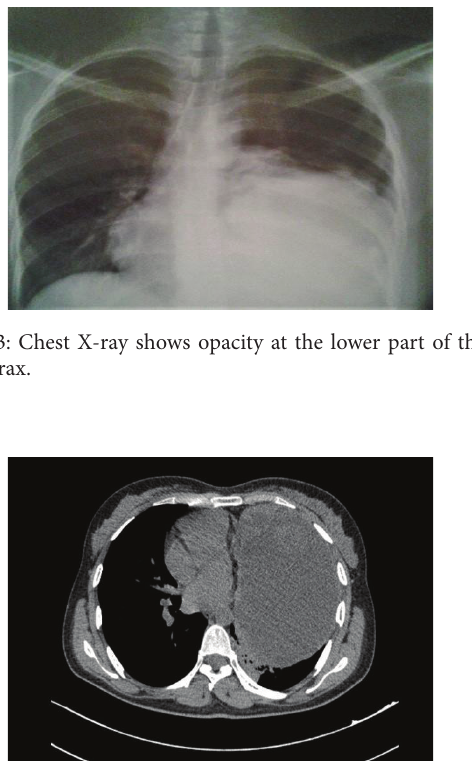
Figure 4: CT scan of chest shows a mass of the left hemithorax, which probably originated in the mediastinum and extended to the whole left pleural